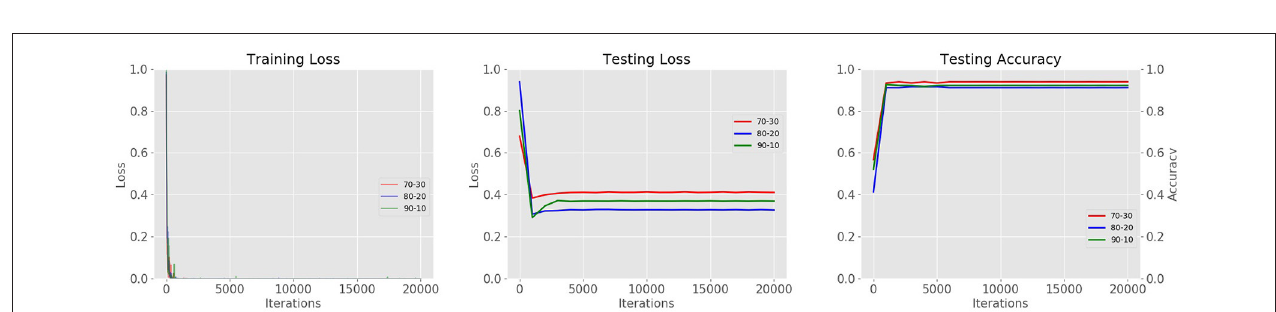
FIGURE 14 | Results of data distribution for cross-validation. Using three different combinations of data (70–30%, 80–20%, 90–10% trainval and testing respectively).